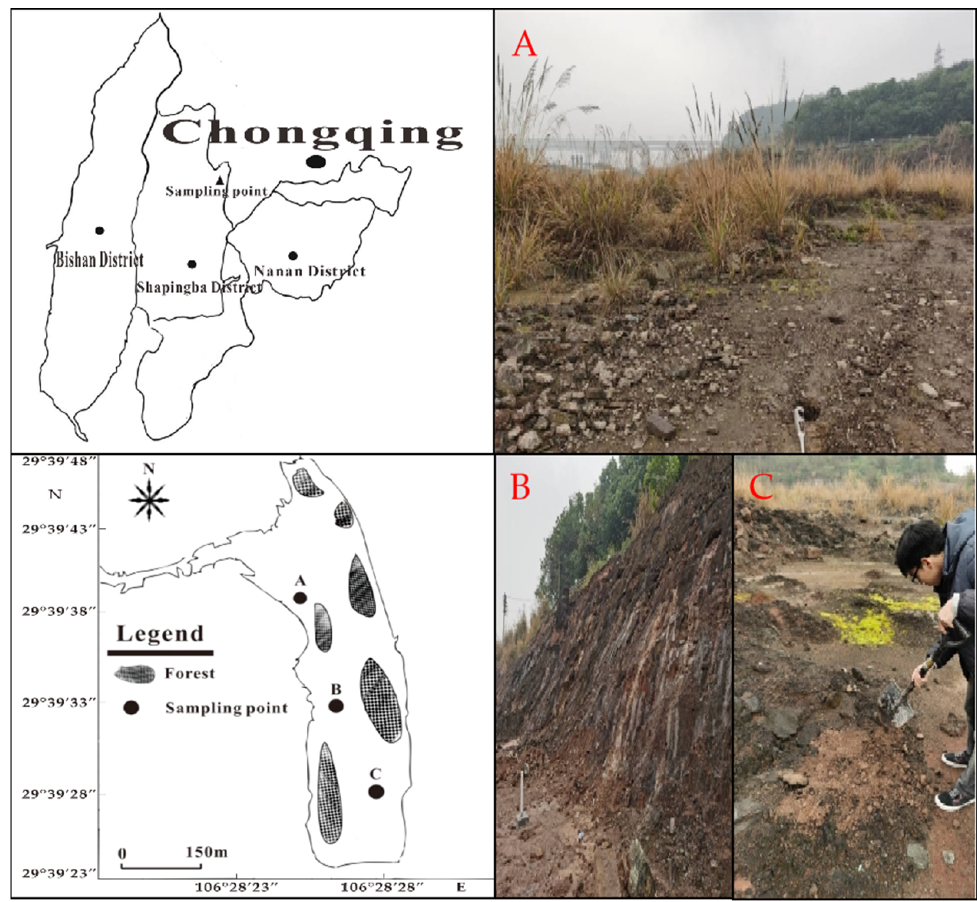
Figure 2. Sampling sites in Chongqing. ( A ) 29 ◦ 39 (cid:48) 40.3 (cid:48)(cid:48) N, 106 ◦ 28 (cid:48) 24.1 (cid:48)(cid:48) E, ( B ) 29 ◦ 39 (cid:48) 32.8 (cid:48)(cid:48) N, 106 ◦ 28 (cid:48) 25.9 (cid:48)(cid:48) E, ( C ) 29 ◦ 39 (cid:48) 28.4 (cid:48)(cid:48) N, 106 ◦ 28 (cid:48) 27.6 (cid:48)(cid:48) E. Table 1. Basic physical and chemical properties of soil samples.